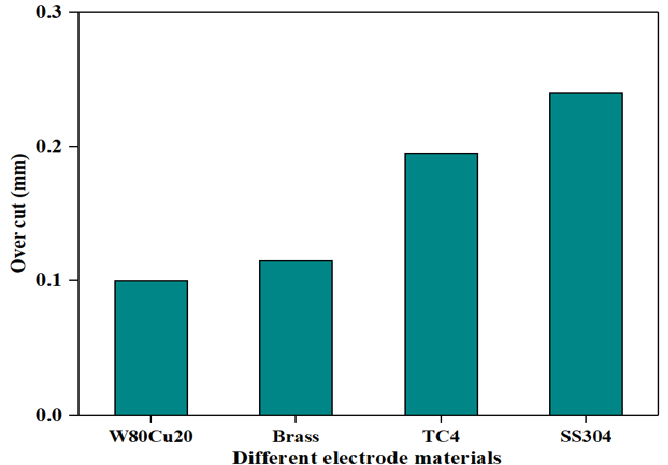
Figure 6. Different tool electrodes’ effects on side overcut under machining conditions T on = 12 μs, T off = 12 μs, I p = 14.17 A.